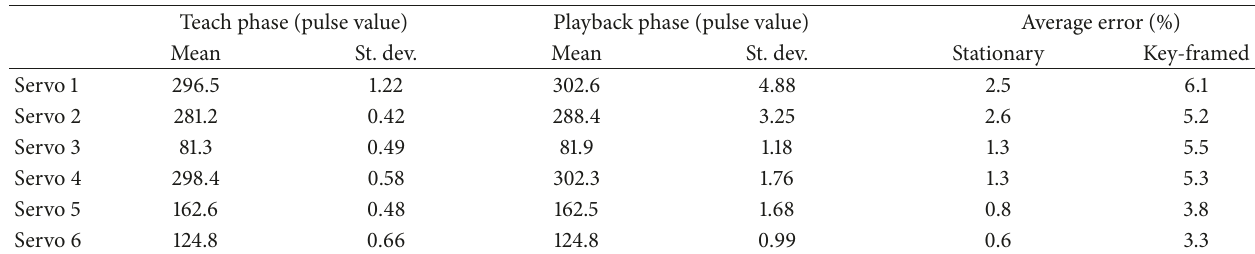
Table 1: Mean pulse and standard deviation values in the “teach” and “playback” phases, and average percentage errors in the stationary and physically key-framed